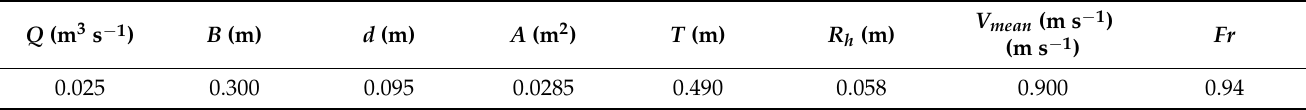
Table 1. The Flow conditions for the submerged vane